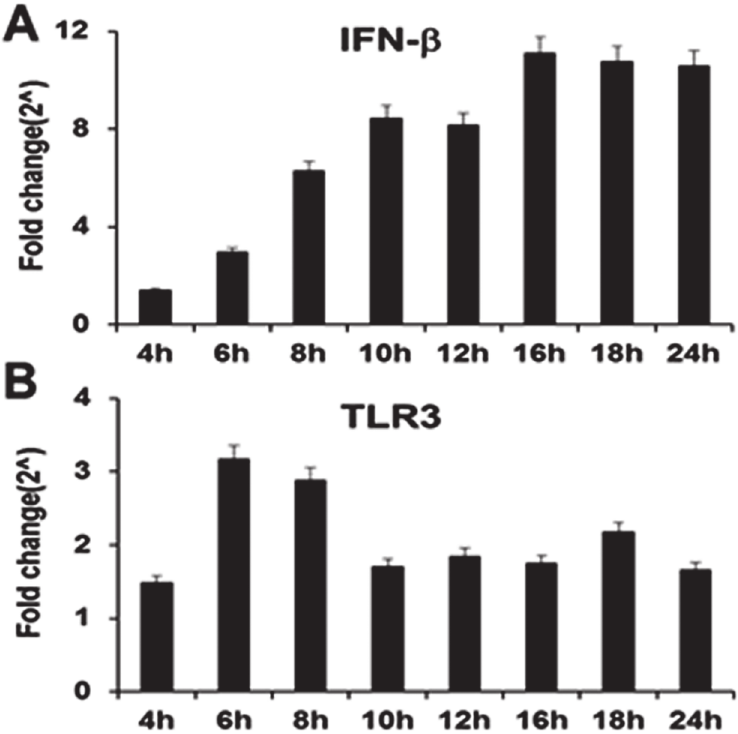
Fig 2. Gene expression levels of IFN- β and TLR3 during the course of C . muridarum infection. Bm1.11 cells were infected with 10 IFU/ cell C . muridarum , and the gene expression levels of: (A) IFN- β and (B) TLR3 were measured by RT-qPCR after total cell mRNA was harvested at each time-point indicated. The results shown are representative of three independent experiments; Fold change is compared to Mock-infected controls